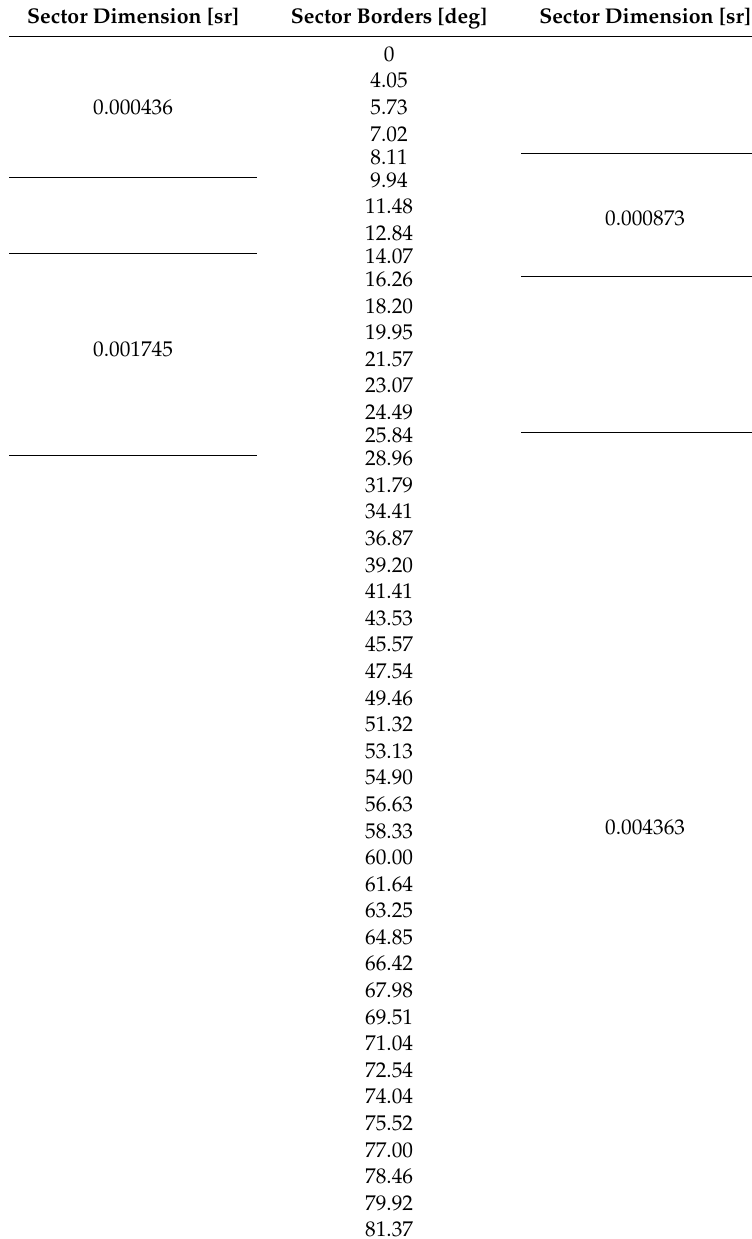
Table 1. The angular boundaries of individual sectors and the sector dimensions expressed as solid angle